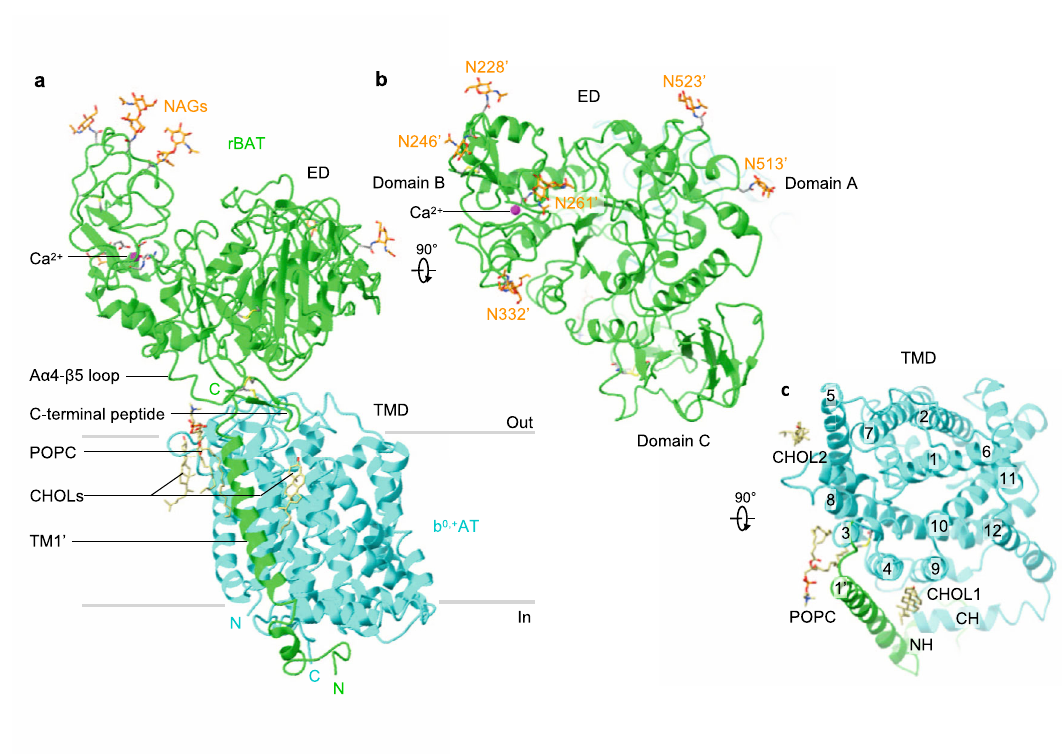
Fig. 2 Structure of the ovine b 0, + AT – rBAT heterodimer. a Detailed depiction of the b 0, + AT – rBAT subcomplex, derived from 3D multi-body re fi nement (see Methods). Note that the complex is re-oriented from Fig. 1e to the membrane normal. CHOL, cholesterol; POPC, palmitoyl oleoyl phosphatidyl choline; TMD; transmembrane domain; ED, ectodomain; NAG, N-acetylglucosamine. b The rBAT ectodomain. The Ca 2 + ion, N-linked glycans, and individual subdomains are labeled. c b 0, + AT complexed with rBAT TM1 ′ . Lipids and individual TMs are labeled. CH, C-terminal helix; NH, N-terminal